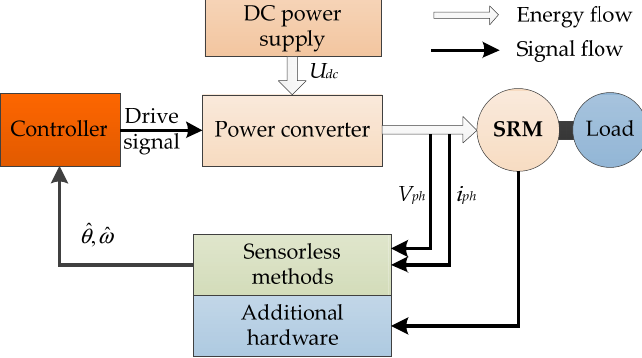
Figure 3. The structure of position sensorless SRM drive system.